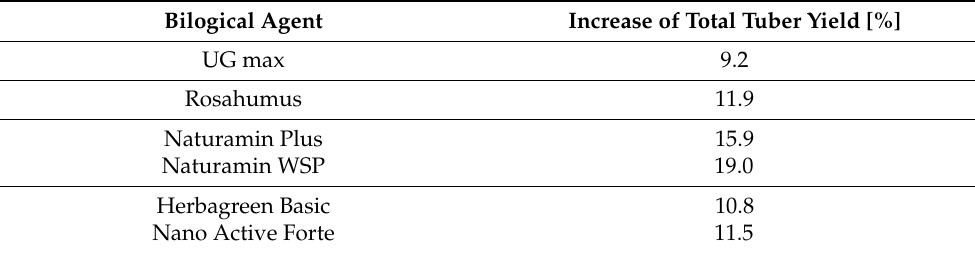
Table 4. Yield increase under the influence of the tested natural preparations (Jadwisin 2004–2020).